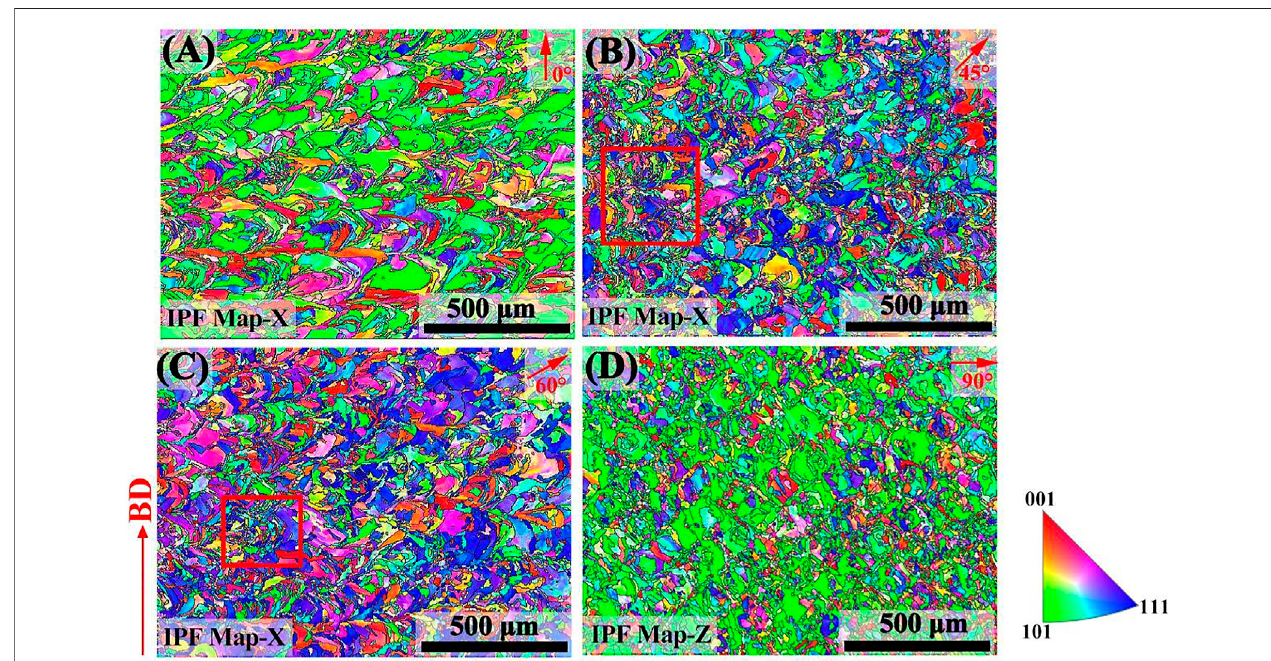
FIGURE 4 | EBSD inverse pole fi gures of SLM-processed 316L SS from different angles relative to the build substrate: (A – D) angle of 0, 45, 60, and 90.